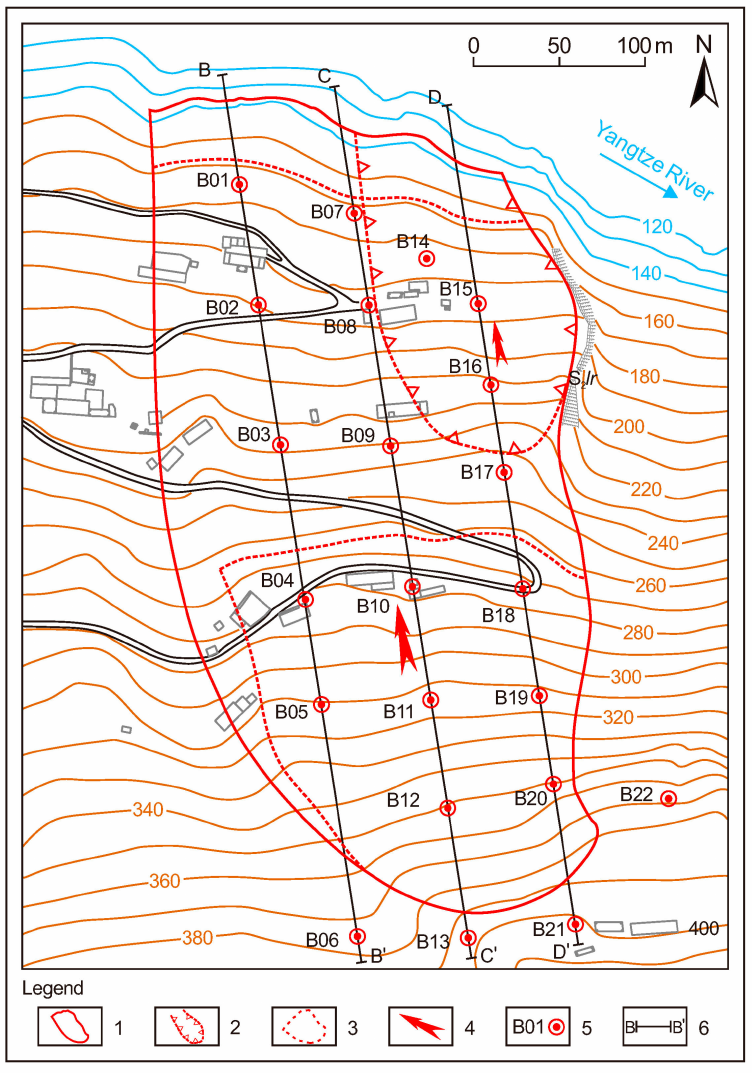
Figure 4. Topographic map of the Ganjingzi landslide, with a contour interval in 10 m increments: ( 1 ) landslide boundary, ( 2 ) boundary of the active zone, ( 3 ) potential boundary of the shallow deformation, ( 4 ) sliding direction, ( 5 ) borehole, and ( 6 ) cross